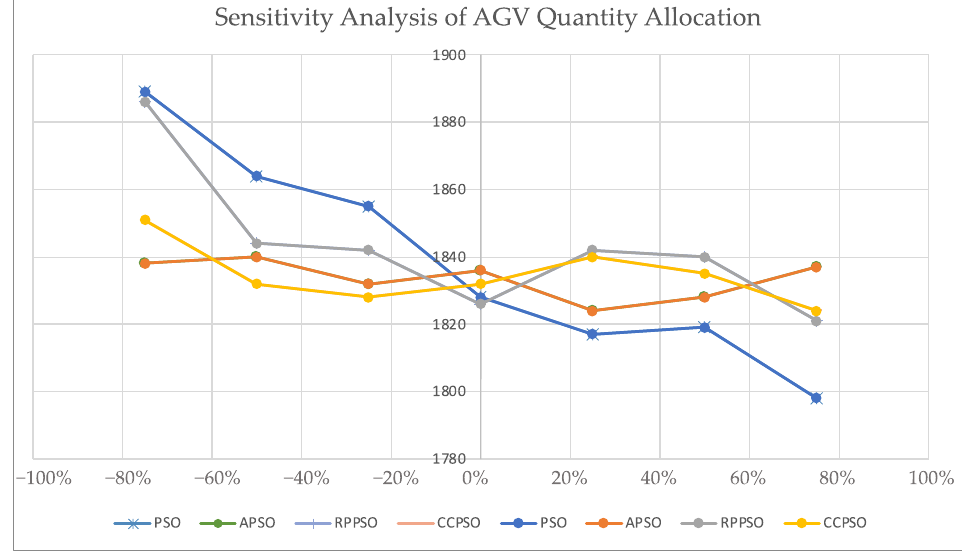
Figure 12. Sensitivity analysis of AGV quantity allocation.